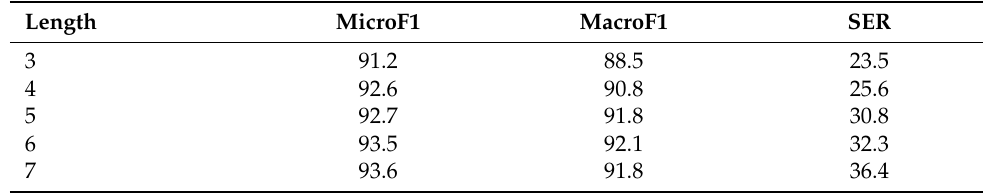
Table 9. Evaluating TunedAraBERT: F1 scores and SER on sanads of different